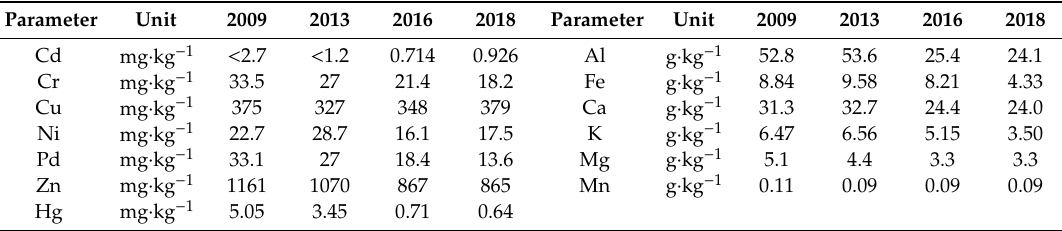
Table A1. Concentrations of common cations in inoculum in recent 10 years.